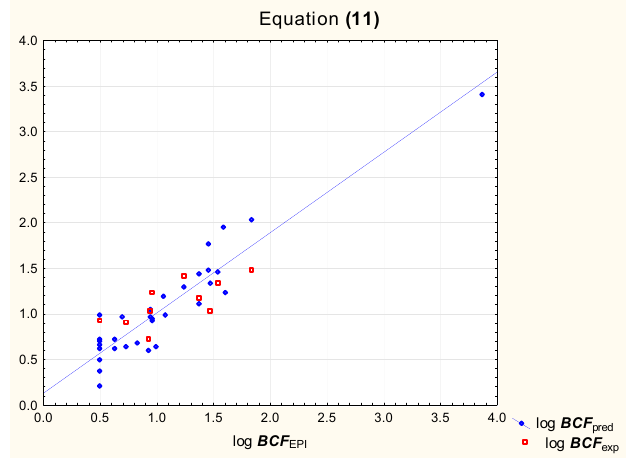
Figure 4. Equation (11)—predicted and experimental log BCF vs. reference values .